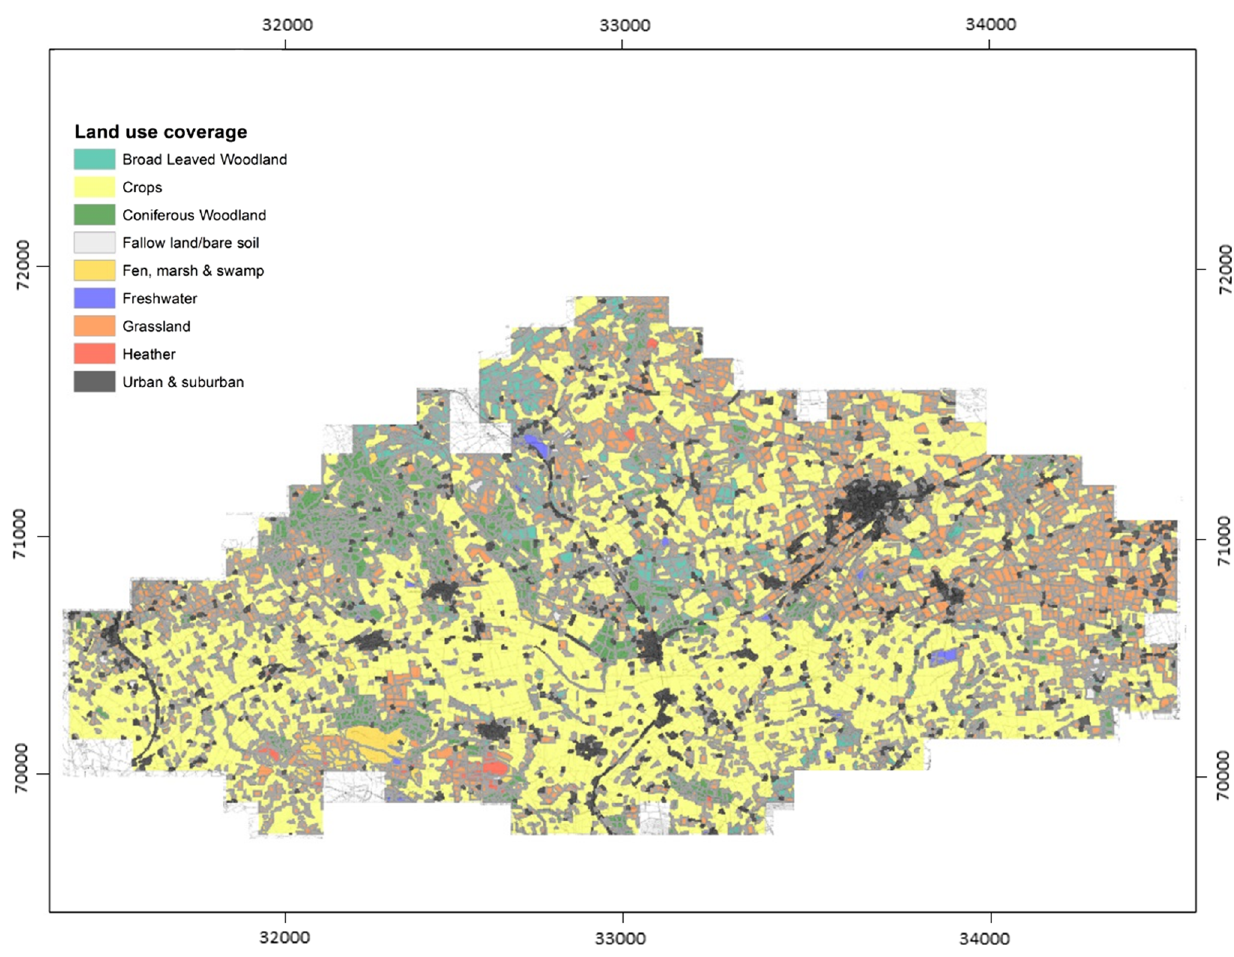
Fig. 5 Land use coverage of the Eden catchment Source: Defra,